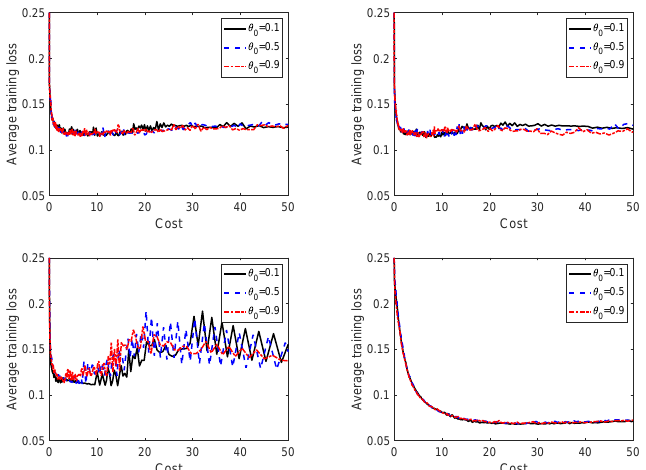
Figure 4. Average training loss versus average computational cost of SIRTR nop equipped with different values for the initial penalty parameter θ 0 . Top row : a8a ( left ) and a9a ( right ). Bottom row : mnist ( left ) and phishing ( right